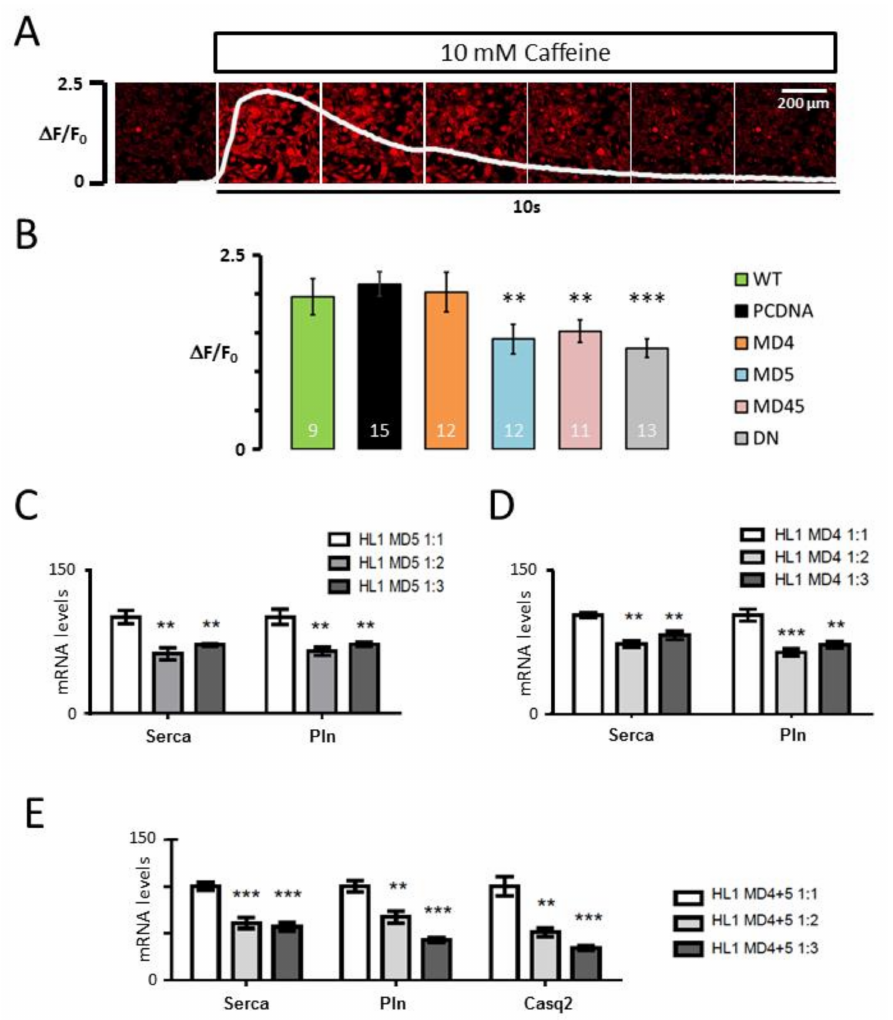
Figure 4. Impact of Pitx2 mutations on SR calcium homeostasis. Panel ( A ). Images recorded during rapid application of 10 mM caffeine with quantification of the resulting transient increase in the calcium signal superimposed. Panel ( B ). Amplitude of the calcium transient peak induced by caffeine in HL1 myocyte cultures transfected with WT, pcDNA, MD4, MD5, MD4+5 or DN constructs. Number of experiments is given for each bar. Transfection of HL1 cardiomyocytes with MD5 (Panel ( C )) and MD4 (Panel ( D )) reduces Serca and Pln mRNA levels. Panel ( E ). Transfection of HL1 cardiomyocytes with MD5 reduces Serca, Pln and Casq mRNA levels. Experiments were carried out in triplicate and repeated in at least three distinct biological samples. Values significantly different from the reference condition are indicated with ** p < 0.01; *** p <